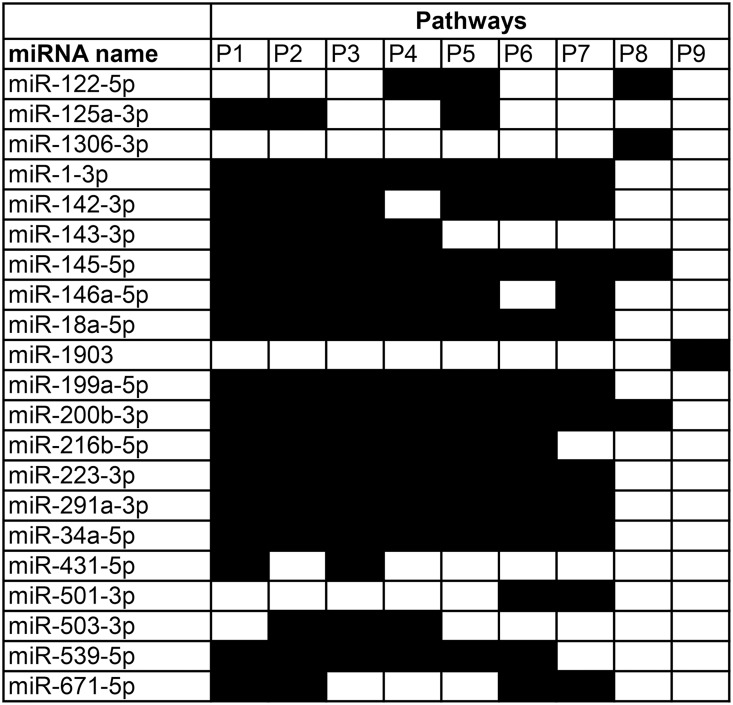
Overlap between miRNA-regulated signaling pathways affected in myopic retina.Diagram depicts miRNA contributions to the 9 miRNA-mRNA signaling cascades associated with form-deprivation myopia in mice.